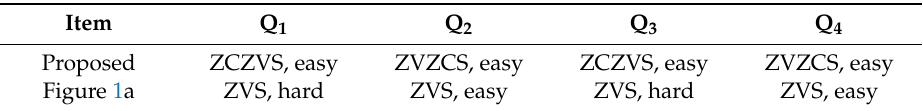
Table 1. Soft switching of the main switches.